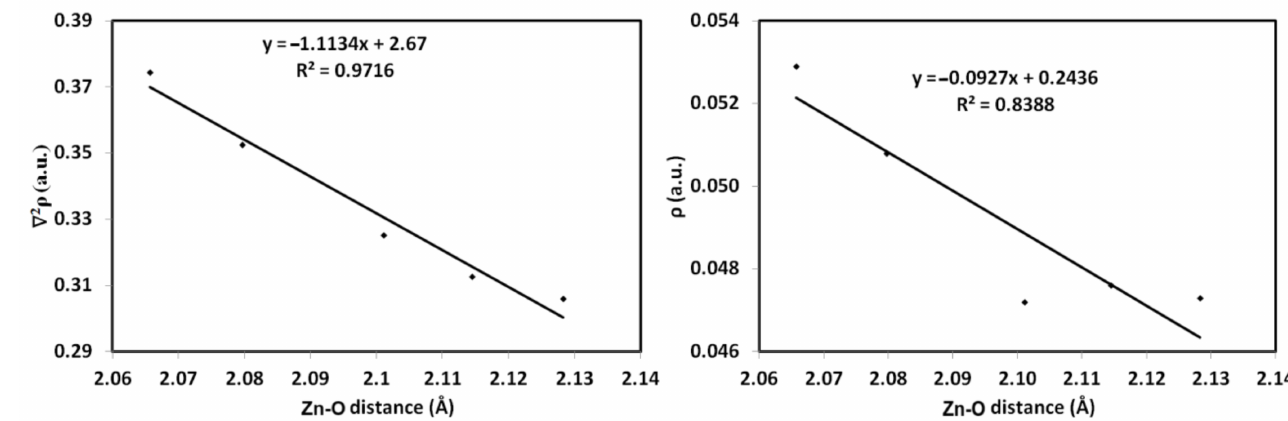
Figure 13. Correlation between the AIM parameters and Zn-O distances.